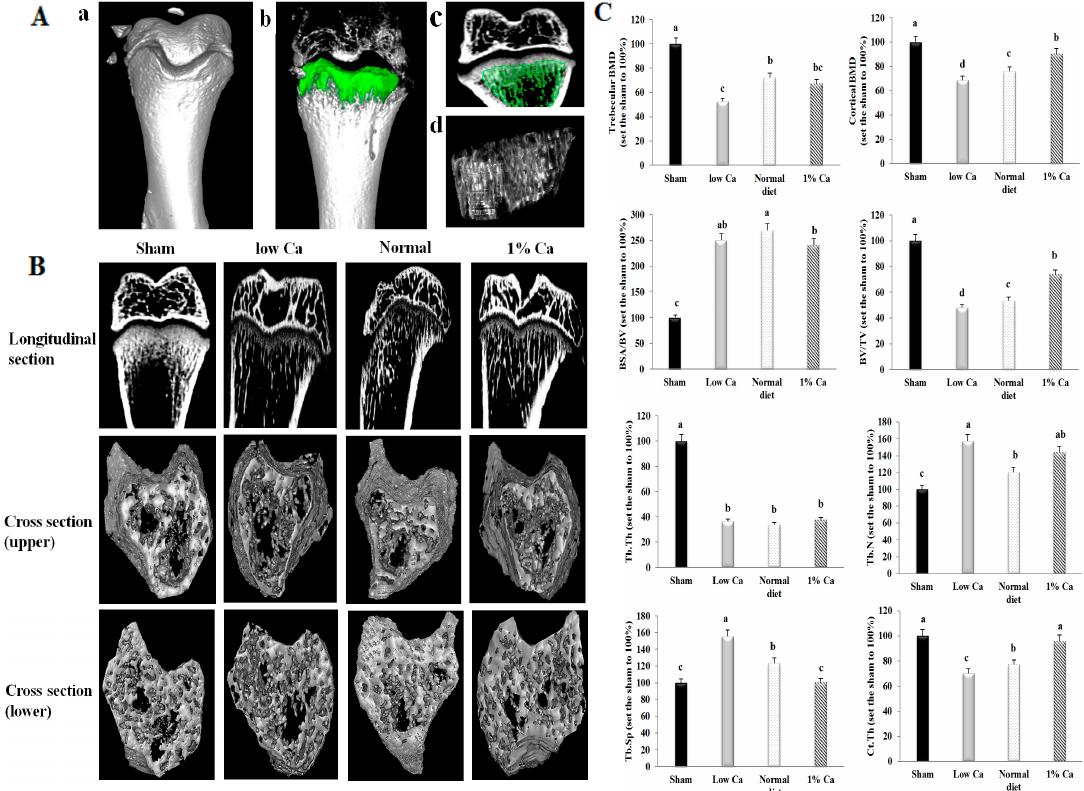
Figure 3. Tibial bone microstructure analyses in rats. ( A ) Process used to analyze trabecular and cortical bone and resulting measurements. a indicates the three-dimensional structure of the tibia, while b shows the three-dimensional green-colored area used to measure tibial parameters. The green-colored area in c indicates the longitudinal section of b. d shows the image of isosurfaces, taken from the green-colored region indicated in b and c. ( B ) Longitudinal section and cross-section of the trabecular in sham, low Ca, normal diet, and 1% Ca groups. ( C ) The micro-CT scanner parameter of trabecular BMD, cortical BMD, tibia bone surface area, volume, thickness, spacing, number and cortical thickness in sham, low Ca, normal diet, and 1% Ca groups. Results are expressed as the means ± standard deviation (SD). Values not sharing a common superscript ( a , b , c and d ) differed significantly (Duncan’s multiple range test).